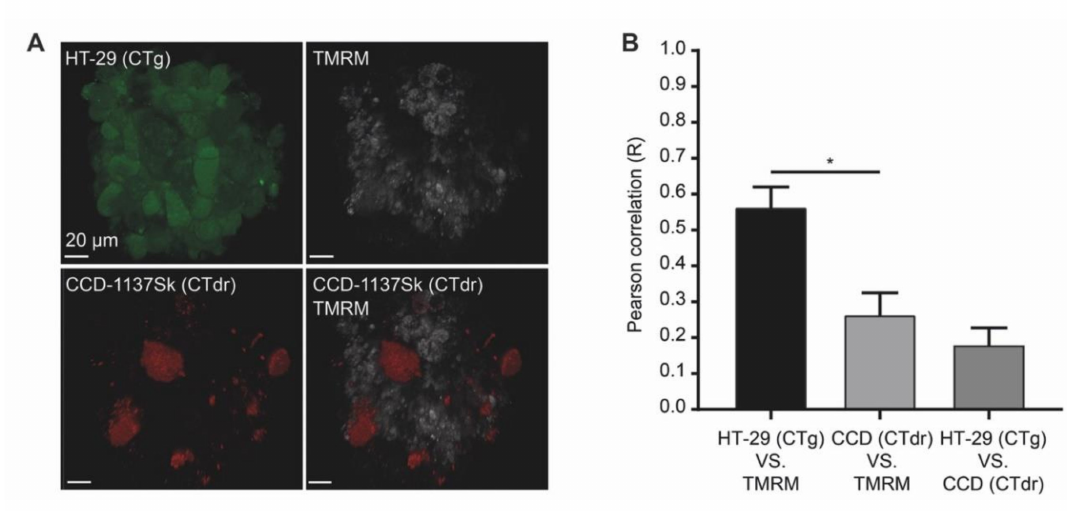
Figure 9. Chip-based 3-D cultures reveal a low mitochondrial membrane potential in fibroblasts upon co-cultivation of HT-29 and CCD-1137Sk cells. Human HT-29 and CCD-1137Sk cells were live stained with CTg and CTdr, respectively, and then co-seeded in Dynarray chips for four days. To evaluate the mitochondrial membrane potential, TMRM was analyzed in 3-D live cell imaging. ( A ) Representative maximum-z projections of fluorescence signals for CTg, CTdr, and TMRM, as indicated. ( B ) Quantitative analysis of Pearson’s correlation between CT-dyes and TMRM as a measure of cell-type-specific TMRM fluorescence intensity. Mean + SEM ( n = 3